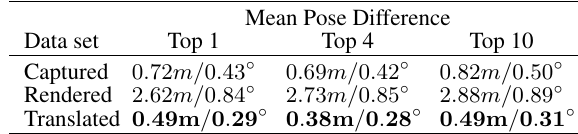
Table 2. Mean pose differences of test image poses to their nearest neighbours from the training data sets. The mean pose differences are computed between each test image and its top 1, top 4 and top 10 nearest neighbours for each training data set. Best results are highlighted in bold